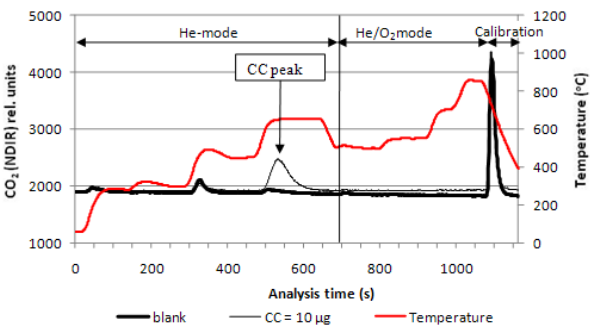
Fig. 4. EUSAAR 2 thermogram for a blank and a CC-loaded filter (10µg) (He-mode: 1–230s, He/O 2 -mode: 231–410s and Calibration-mode: 410–510s). The vertical line represents the splint point between OC and EC. The response of the NDIR de- tector is given in relative units.